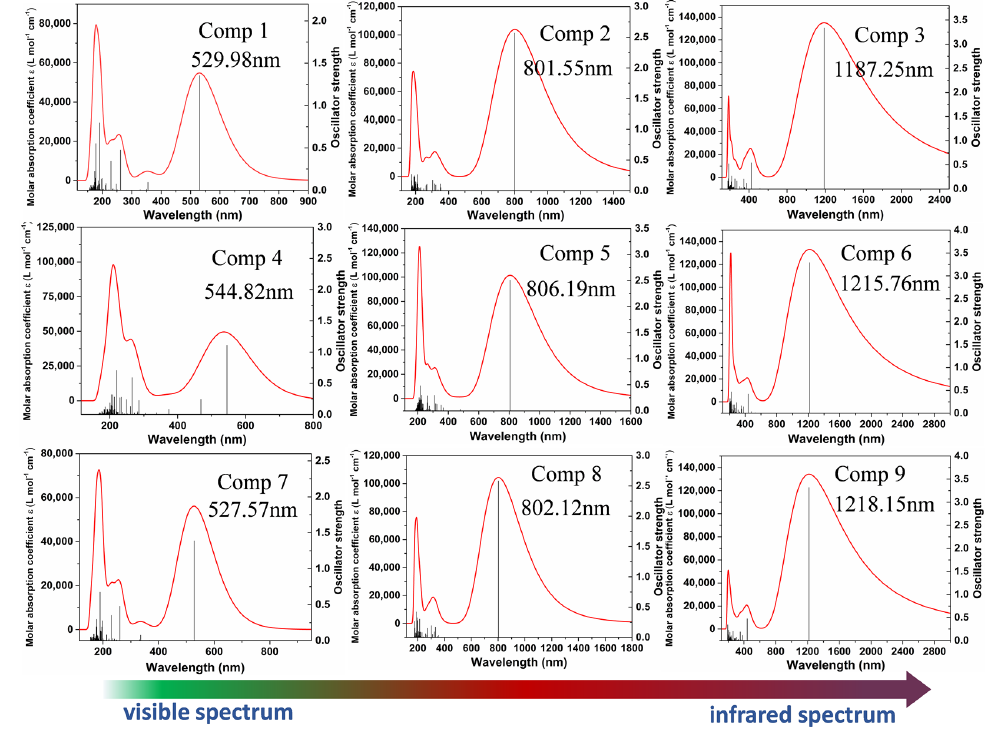
Table 3. Excitation energy ( E ), oscillator strengths ( f ), wavelengths ( λ max ), and MO contributions of the compounds.